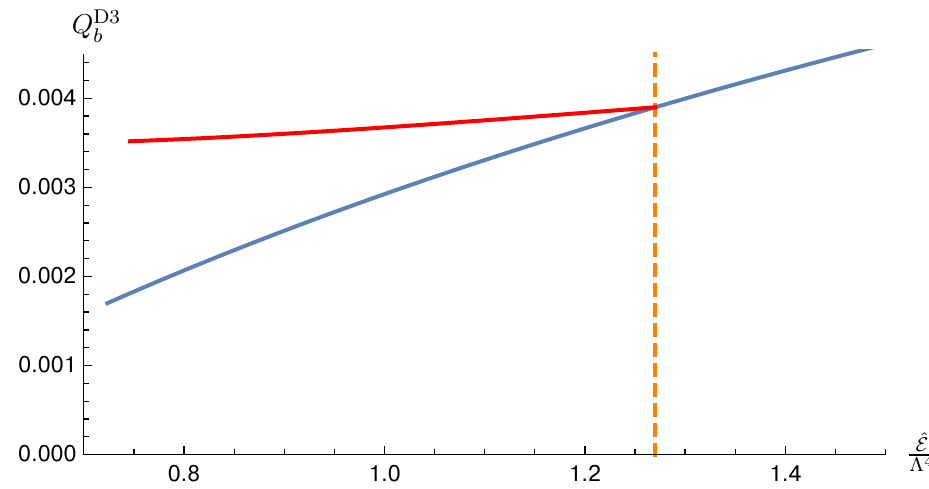
Figure 3 . The Maxwell D3-brane charge of Klebanov-Tseytlin black holes (solid blue line) and Klebanov-Strassler black holes (solid red line). Dashed orange line indicates onset of the pertur- bative instability of KT black holes, spontaneously breaking U(1) point of the evolution of the instability of a KT black hole for isotropy constraints of the horizon, is a KS black hole at the corresponding energy